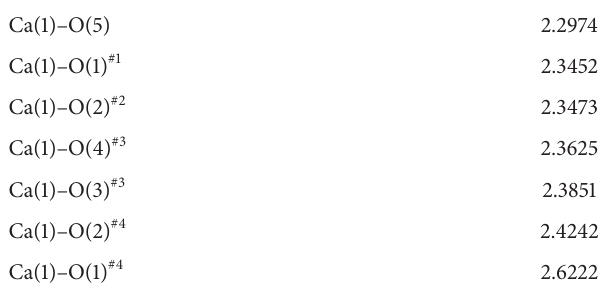
Table 2: Selected bond lengths (˚A) for the